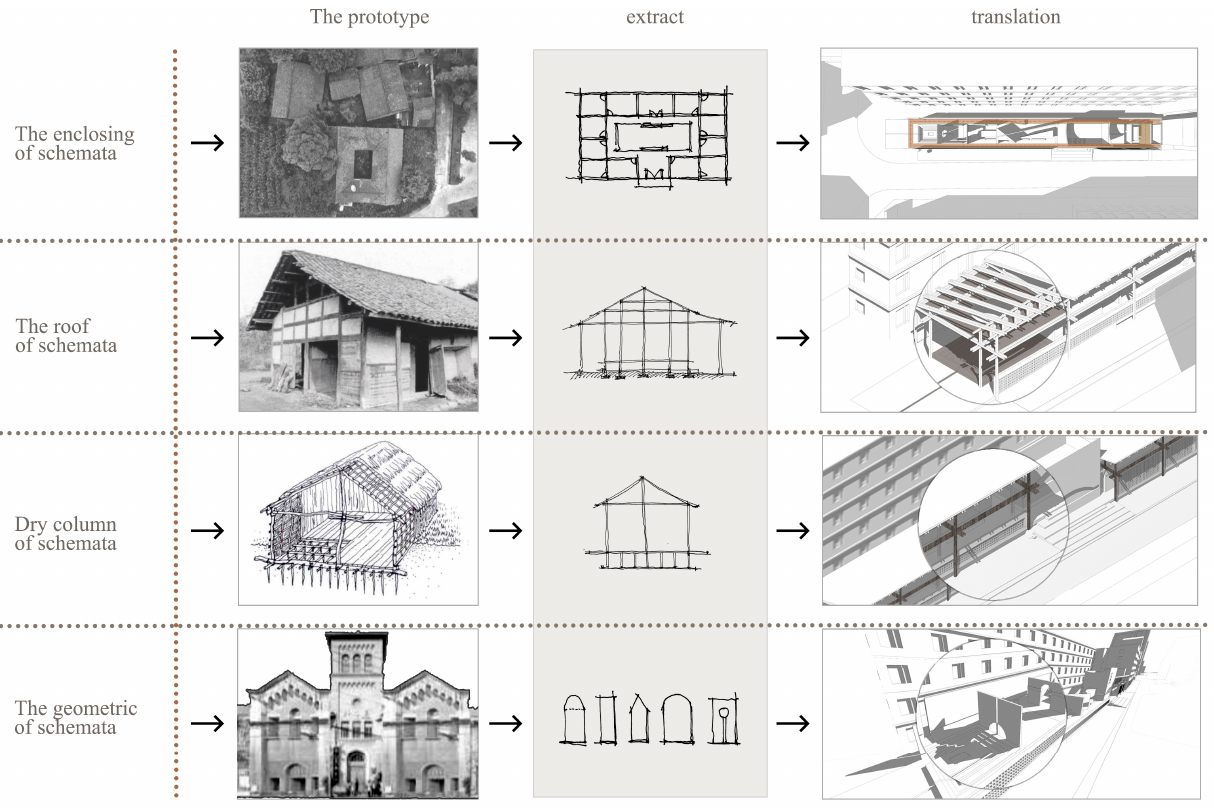
Figure 12. Design Elements and Historical Context.